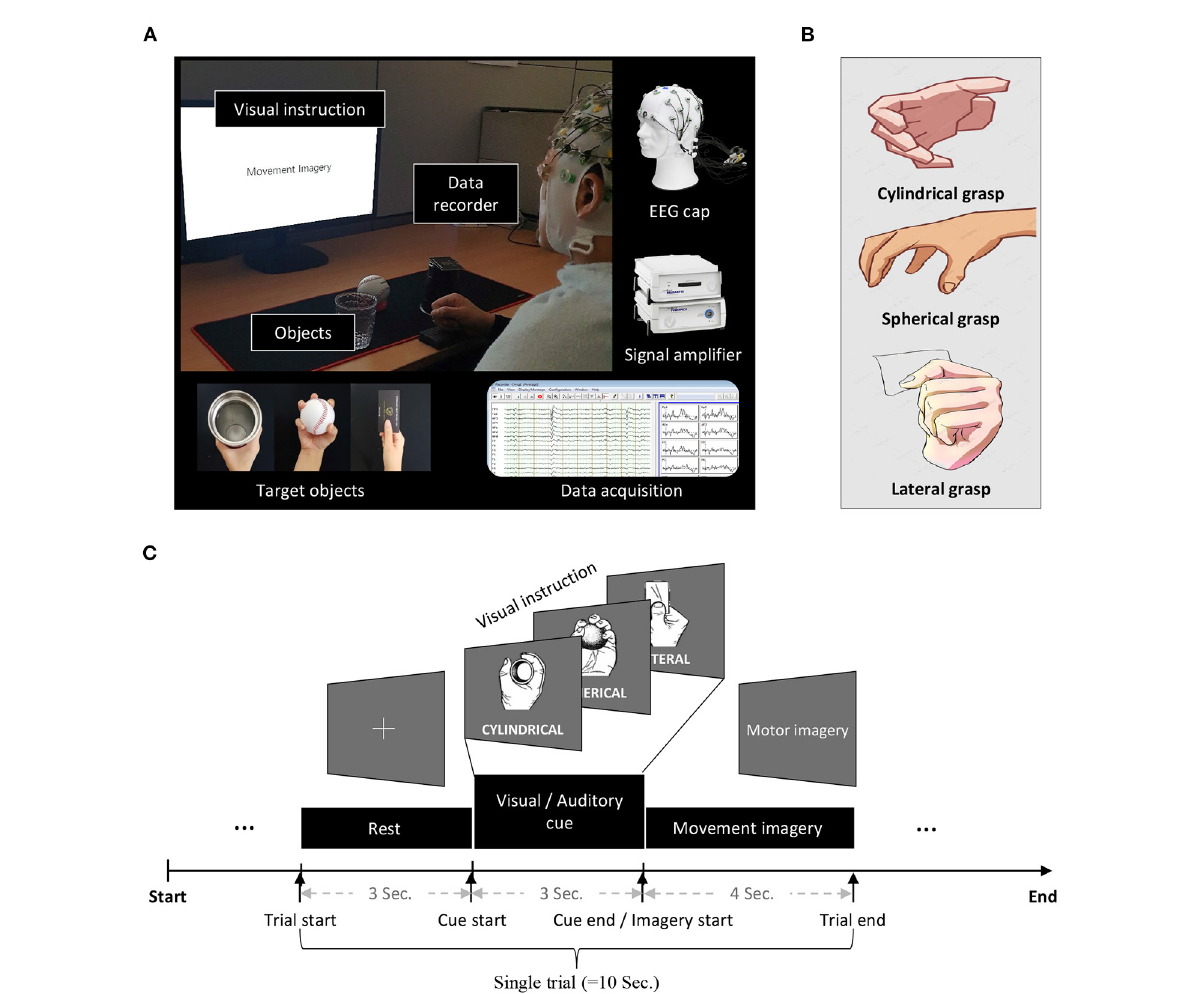
FIGURE9 Experimental setup and protocols. Dataset was recorded under three sessions, and the datasets from the first two sessions (day 1 and day 2) was released for training purposes. The test data released later to competitors was obtained in the third session. (A) During a session of